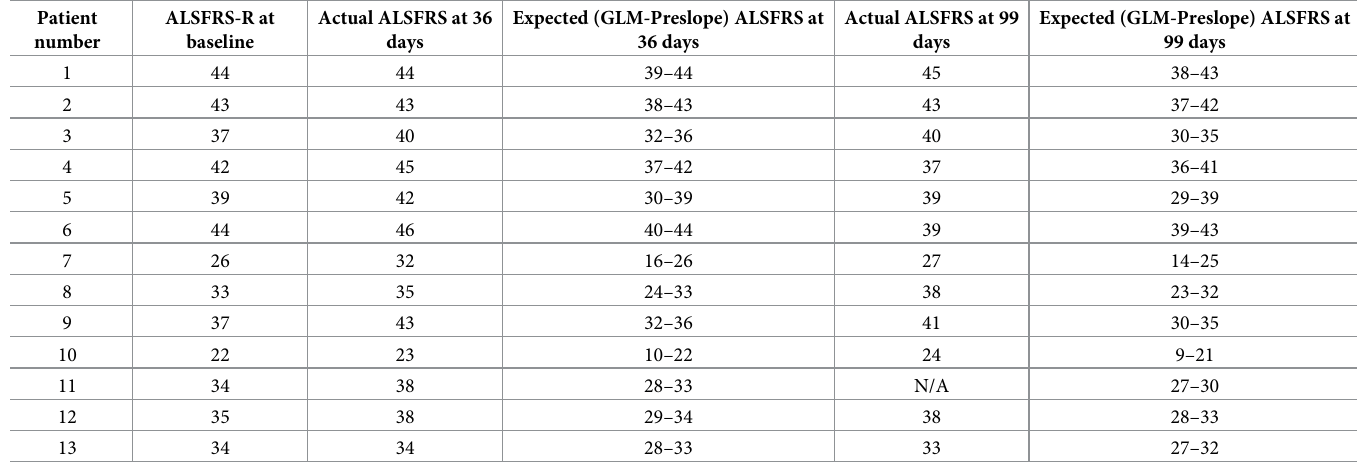
Table 7. Comparison of actual and expected (predicted by GLM and preslope models) ALSFRS-R scores for individual patients at Visit 2 (V2 at Day 1; prior to first ILB 1 injection), Visit 7 (V7 at Day 36; 7 days after last ILB 1 injection) and Visit 10 (V10 at Day 99; 70 days after last ILB 1 injection); (N/A = data not available). Patient